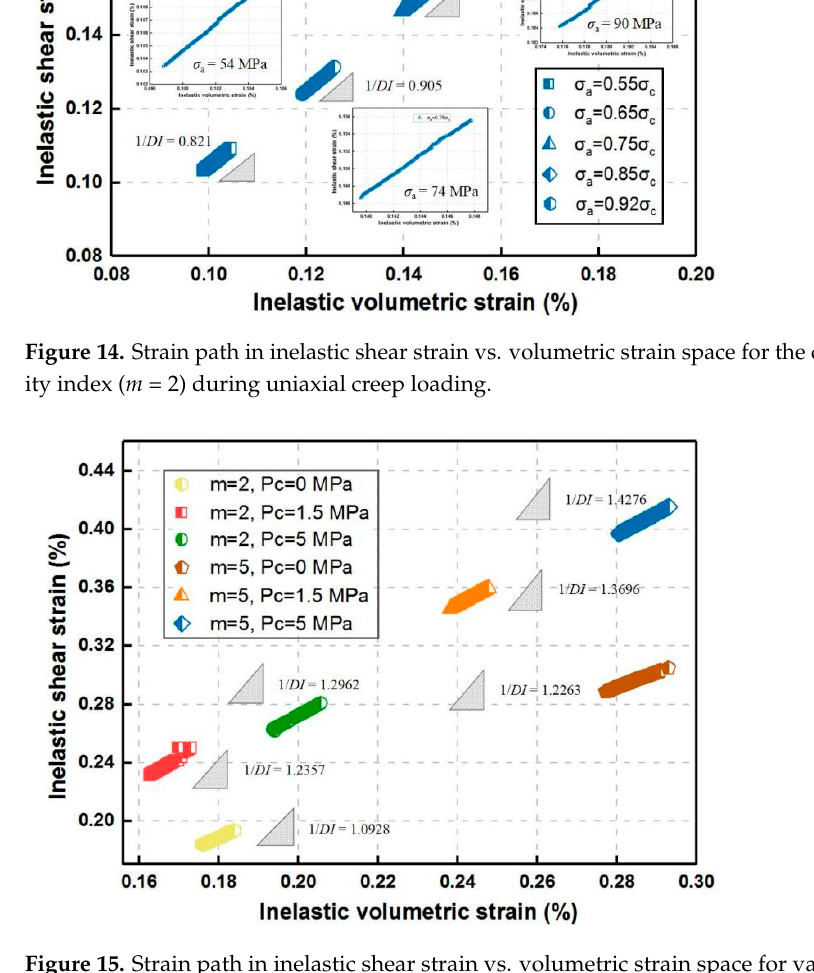
Figure 15. Strain path in inelastic shear strain vs. volumetric strain space for various homogeneity indexes during triaxial creep loading.